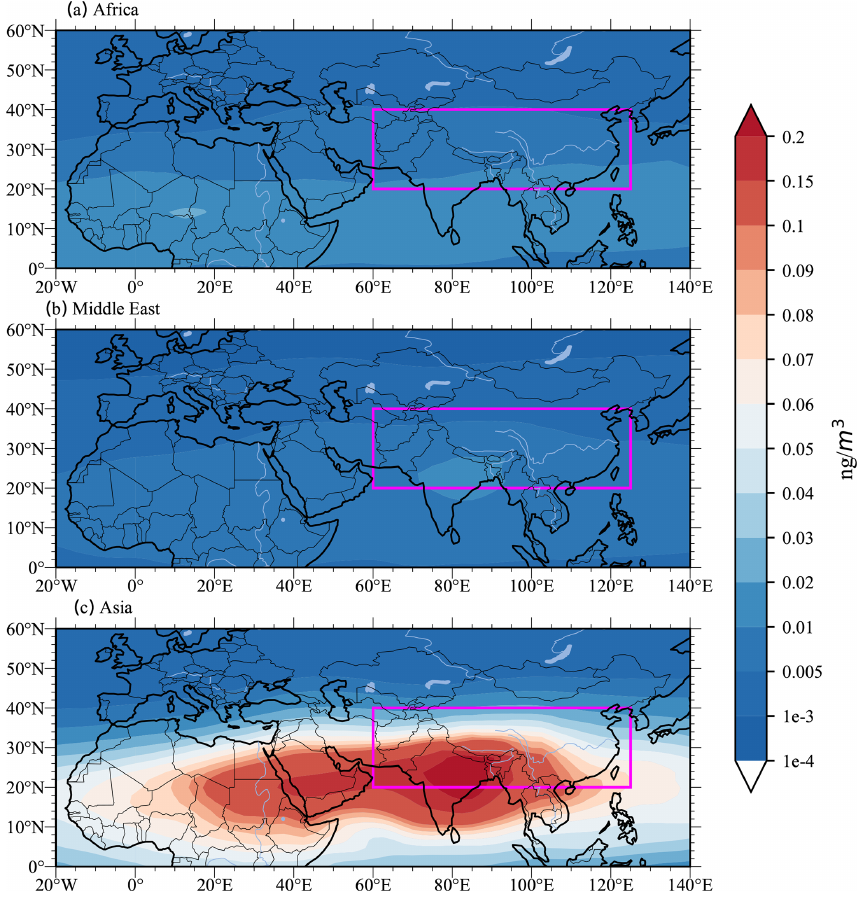
Figure 10. Simulated mass concentrations of North African, Middle Eastern, and Asian dust at 100hPa (left) averaged in June–July–August (JJA) from the year 2014 to 2018. Purple boxes denote the Asian summer monsoon